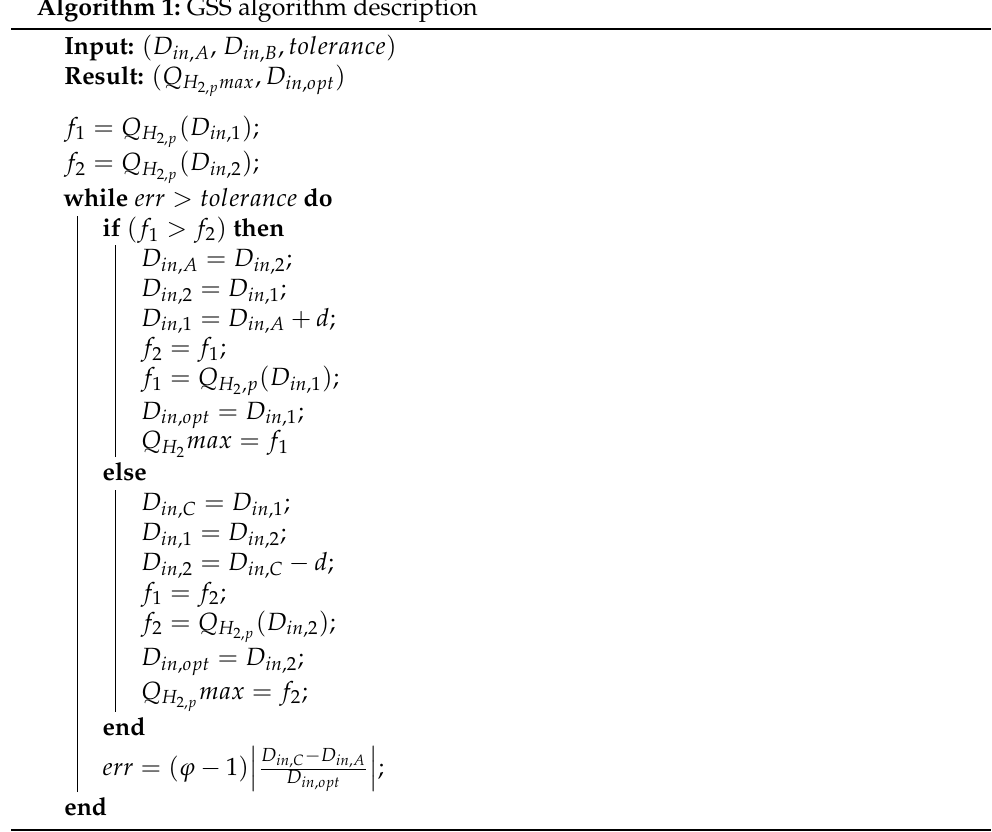
Figure 5. Eigenvalues of the MEC model (1)–(3) linearized in the operating region. Algorithm 1: GSS algorithm